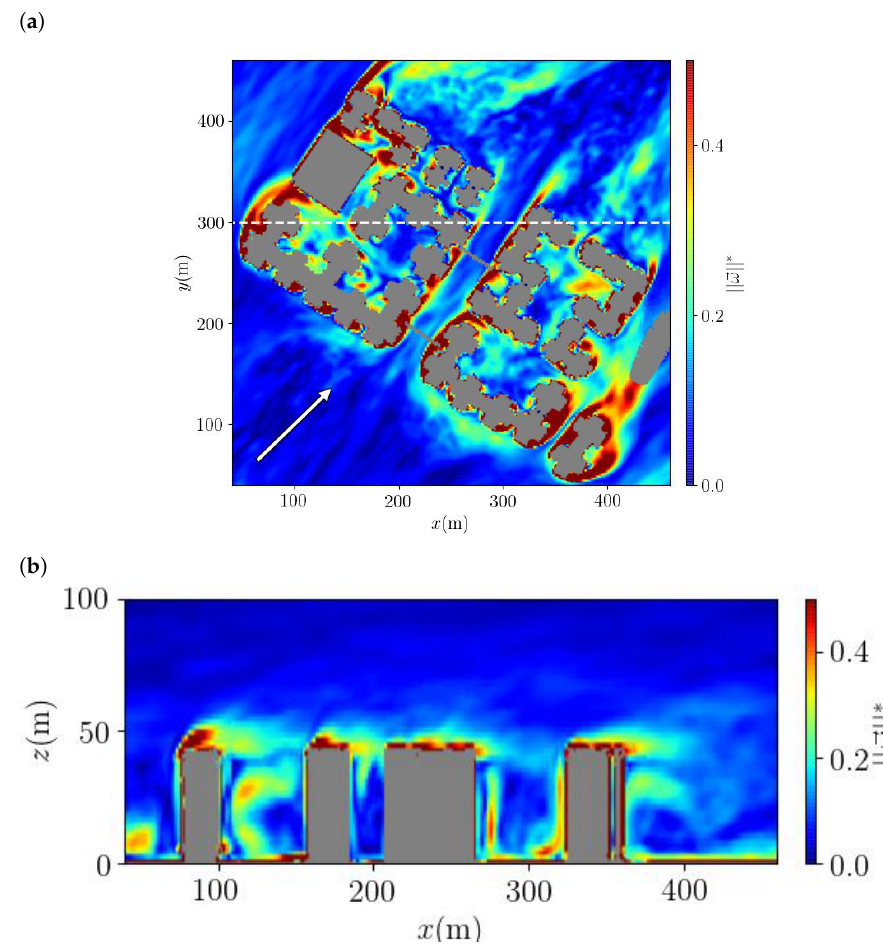
Figure 11. Time-averaged normalised vorticity magnitude for the homogeneous neighbourhood and an external wind at 45° (indicated by the arrow): ( a ) x y = 300 m (indicated by the white dashed line in panel a